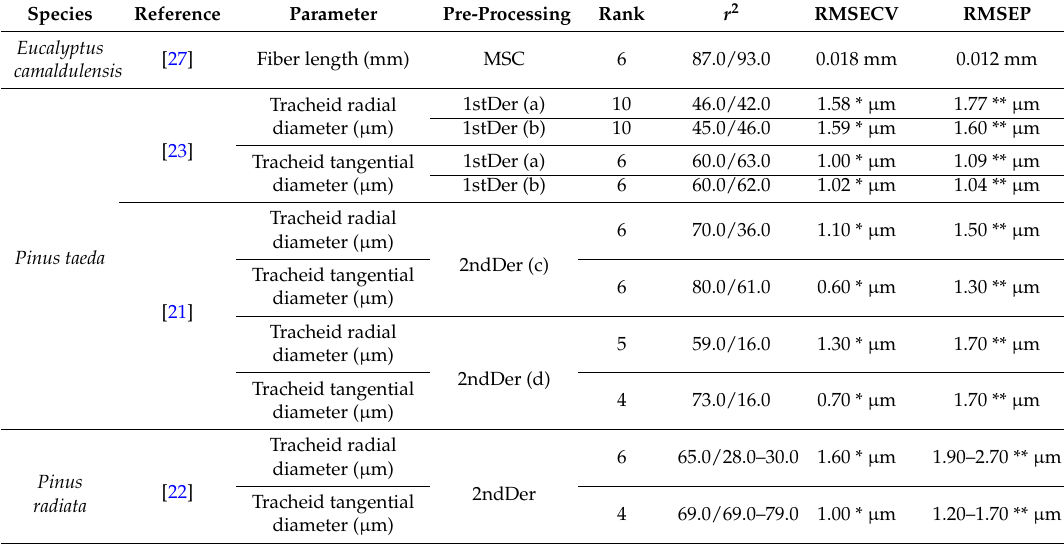
Table 5. Model characteristics for some cellular morphological properties of wood using NIR spectroscopy published in the